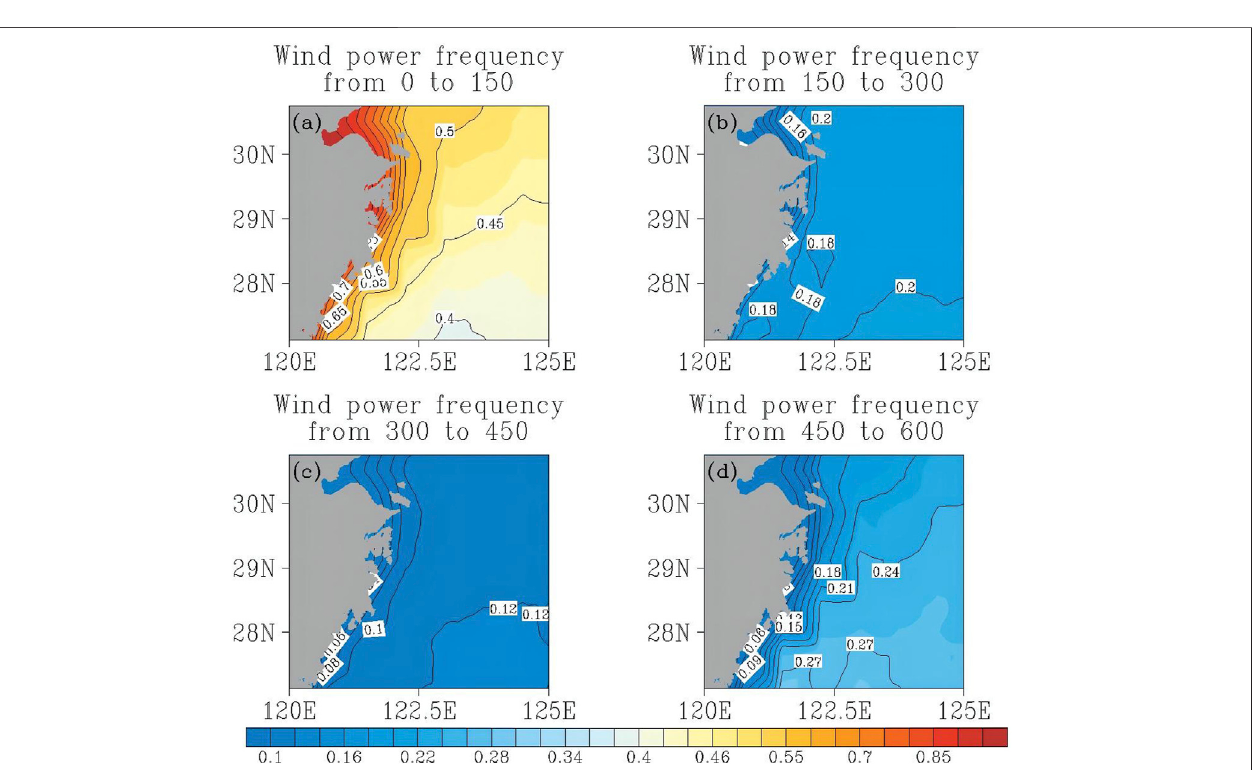
FIGURE12| Frequencydistributionofwindenergyresourcesonthecoastalseasurface:(a)thefrequencyofDwpfrom0to150;(b)thefrequencyofDwpfrom150 to 300; (c) the frequency of Dwp from 300 to 450; (d) the frequency of Dwp from 450 to 600.